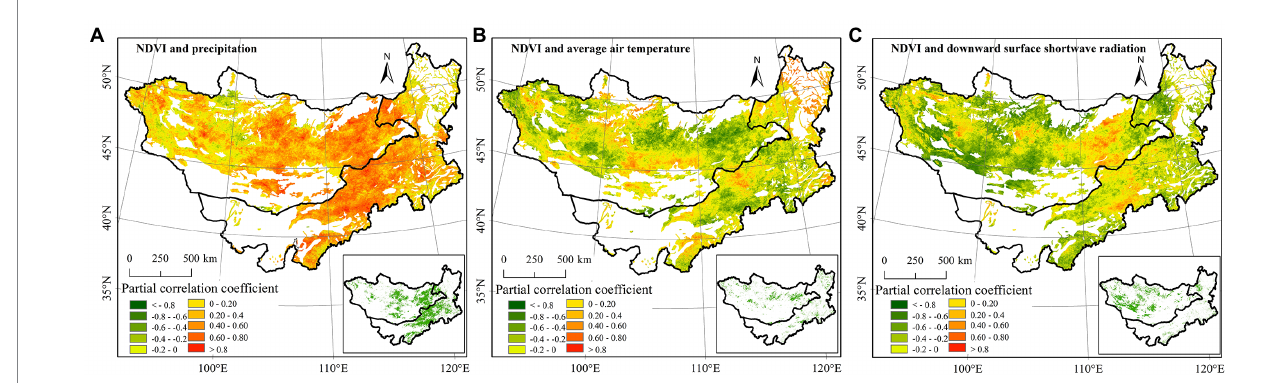
FIGURE 5 Spatial distribution of partial correlation coefficient of growing season NDVI and (A) precipitation, (B) average air temperature, and downward surface shortwave radiation (C) on Mongolian Plateau.